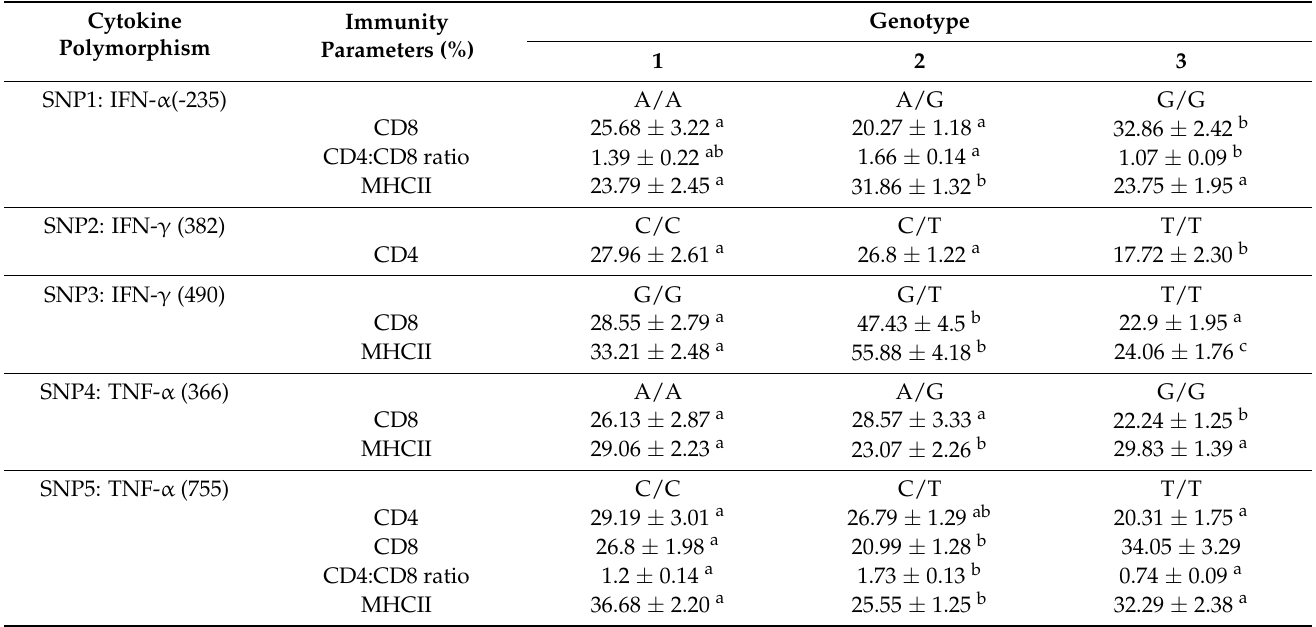
Table 3. Effects of SNPs in cytokine genes on the expressions of immunity parameters in pig